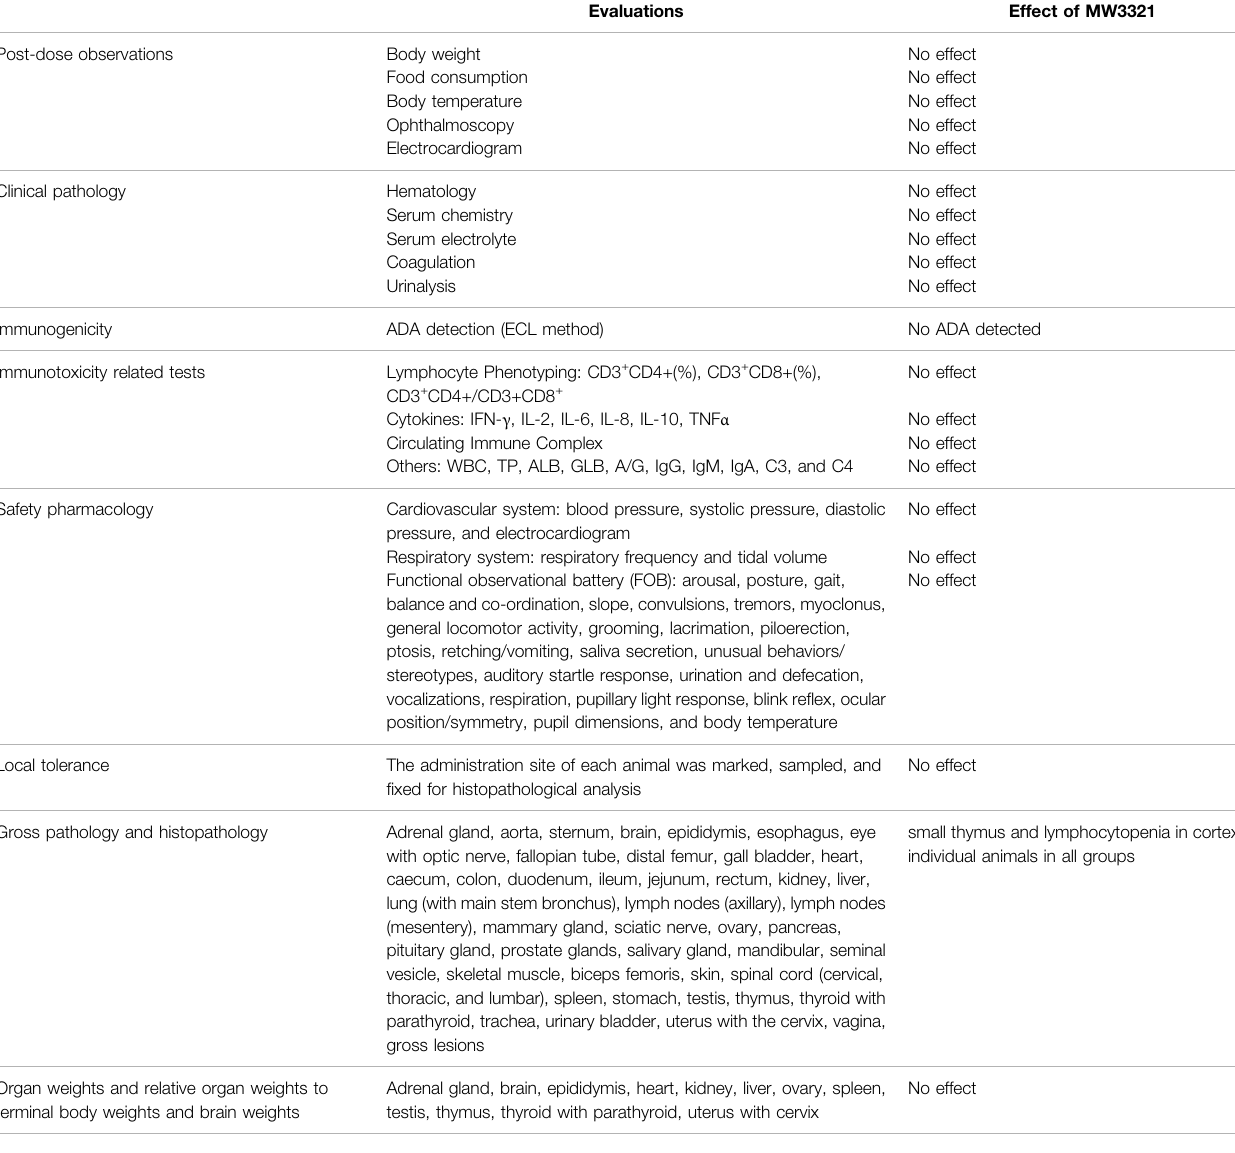
TABLE 1 | Toxicology study of MW3321.